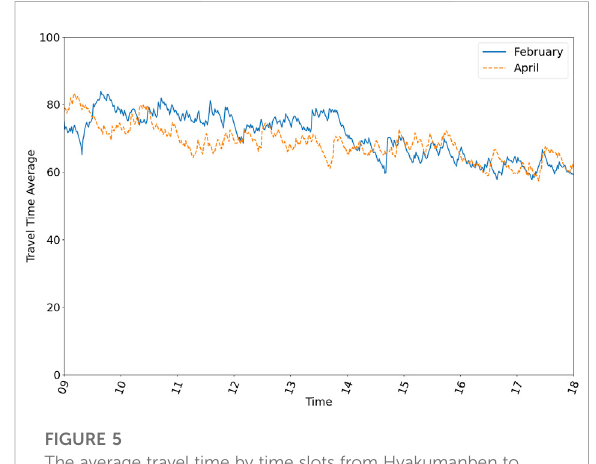
FIGURE 5 The average travel time by time slots from Hyakumanben to Kyoto Station is compared between February (blue line) and April (broken red line). The results show that the travel time is shorter in April during the morning hours and almost the same from approximately14:00onward.Note,however,thatthisincludesthe waiting time for travel, which may be unrealistic if the number of data is insuf fi